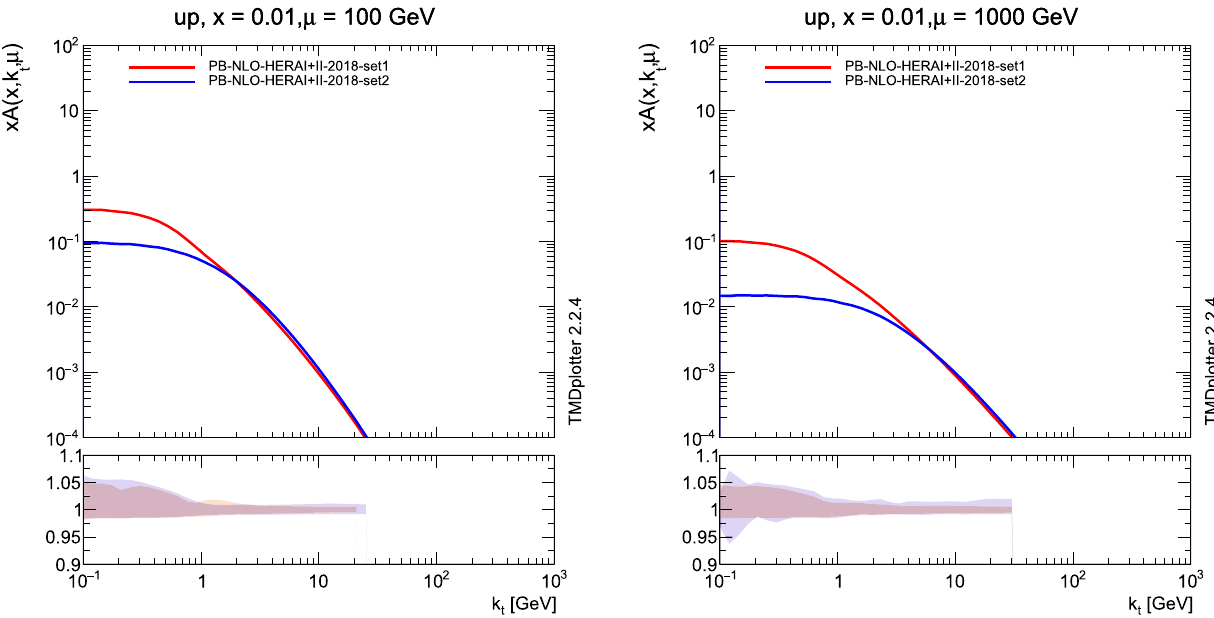
Fig. 2 TMD parton density distributions for up quarks (PB-NLO-2018-Set 1 and PB-NLO-2018-Set 2) as a function of k T at μ = 100 and 1000 GeV and x = 0 . 01. In the lower panels show the full uncertainty of the TMDs, as obtained from the fits [51]